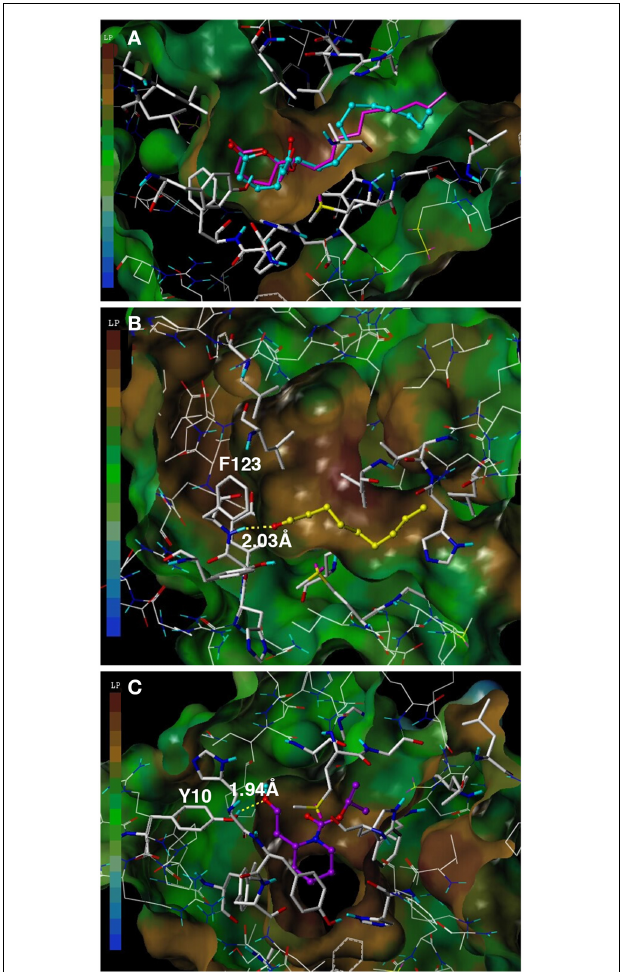
FIGURE 4 | Docking of ligands into CquiOBP1. (A) Re-docked MOP (cyan) and MOP as observed in the CquiOBP1-MOP crystal complex (Mao et al., 2010). (B) Nonanal bound to the main cavity and stabilized by a hydrogen bond with the main chain of Phe-123. (C) Picaridin bound in the same cavity, but having a different orientation and the hydroxyl group forming a hydrogen bond with the side chain of Tyr-10. Figures were generated with Sybyl